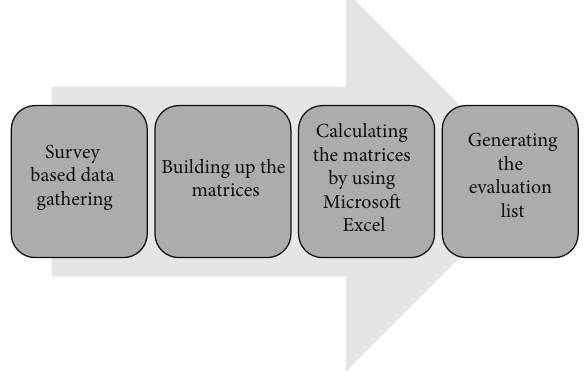
Figure 3: Process of categorizing innovation performance